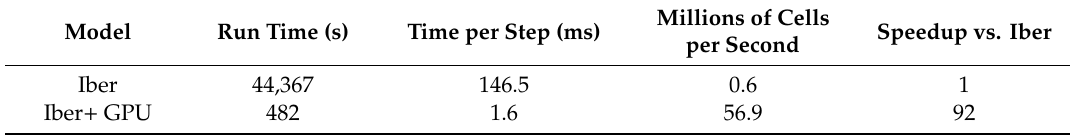
Table 4. Performance measurements obtained for the fourth test